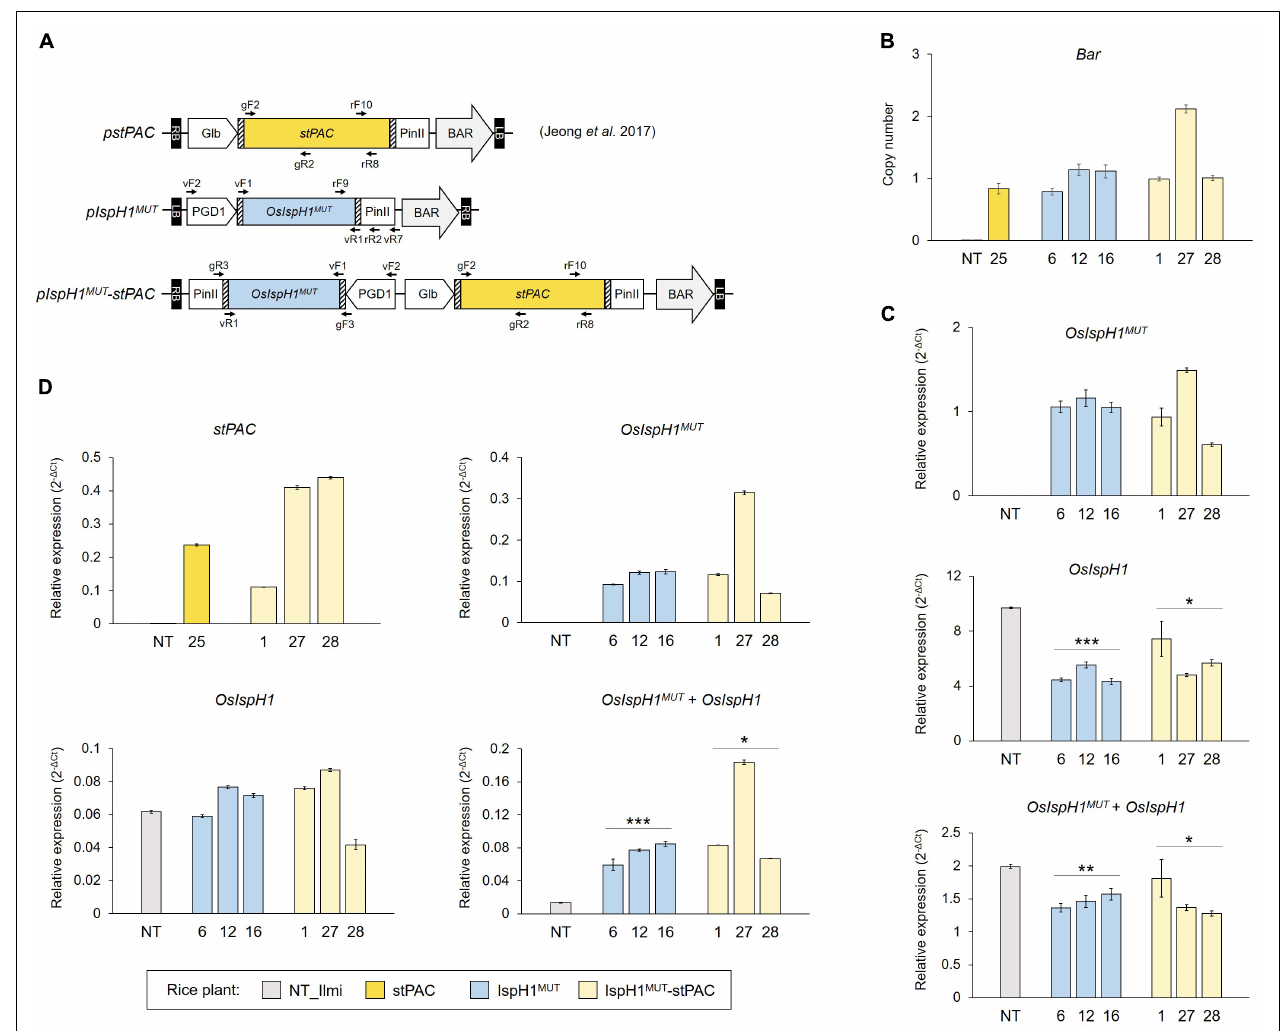
FIGURE 5 | Generation of transgenic rice plants for in planta characterization. (A) Schematic representation of binary vectors for rice transformation with the indicated positions of primer sets listed in Supplementary Table 10 . (B) TaqMan PCR to verify the transgene copy numbers using bialaphos-resistant (Bar) gene cassette. The previously reported homozygous stPAC 25 line was used as a reference for the single T-DNA insertion (Jeong et al., 2017). The qRT-PCR to examine transcript levels of transgenes, OsIspH1 MUT or stPAC , endogenous OsIspH1 , and combined genes, OsIspH1 MUT and OsIspH1 , in transgenic rice leaves (C) and seeds (D) , respectively. The rice ubiquitin gene (Os01g22490) was used as an internal reference for quantitative normalization, and the values were represented as the mean ± SE of three independent measurements. Statistical analyses were performed using a one-tailed Student’s t -test, and significant differences were indicated by a p -value (* p < 0.05, ** p < 0.01, and *** p <